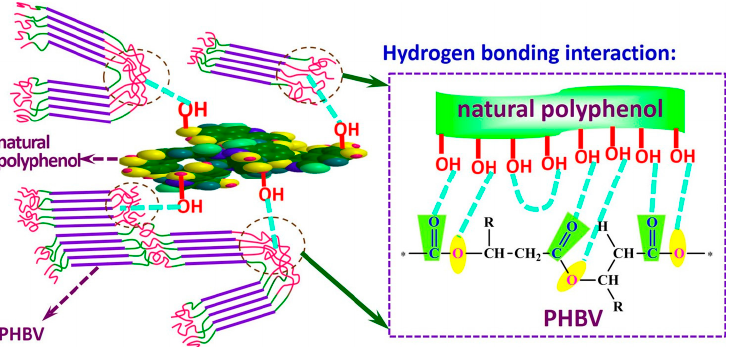
Figure 6. Schematic diagram of the formation of hydrogen bonding interaction between PHBHV and natural polyphenol.